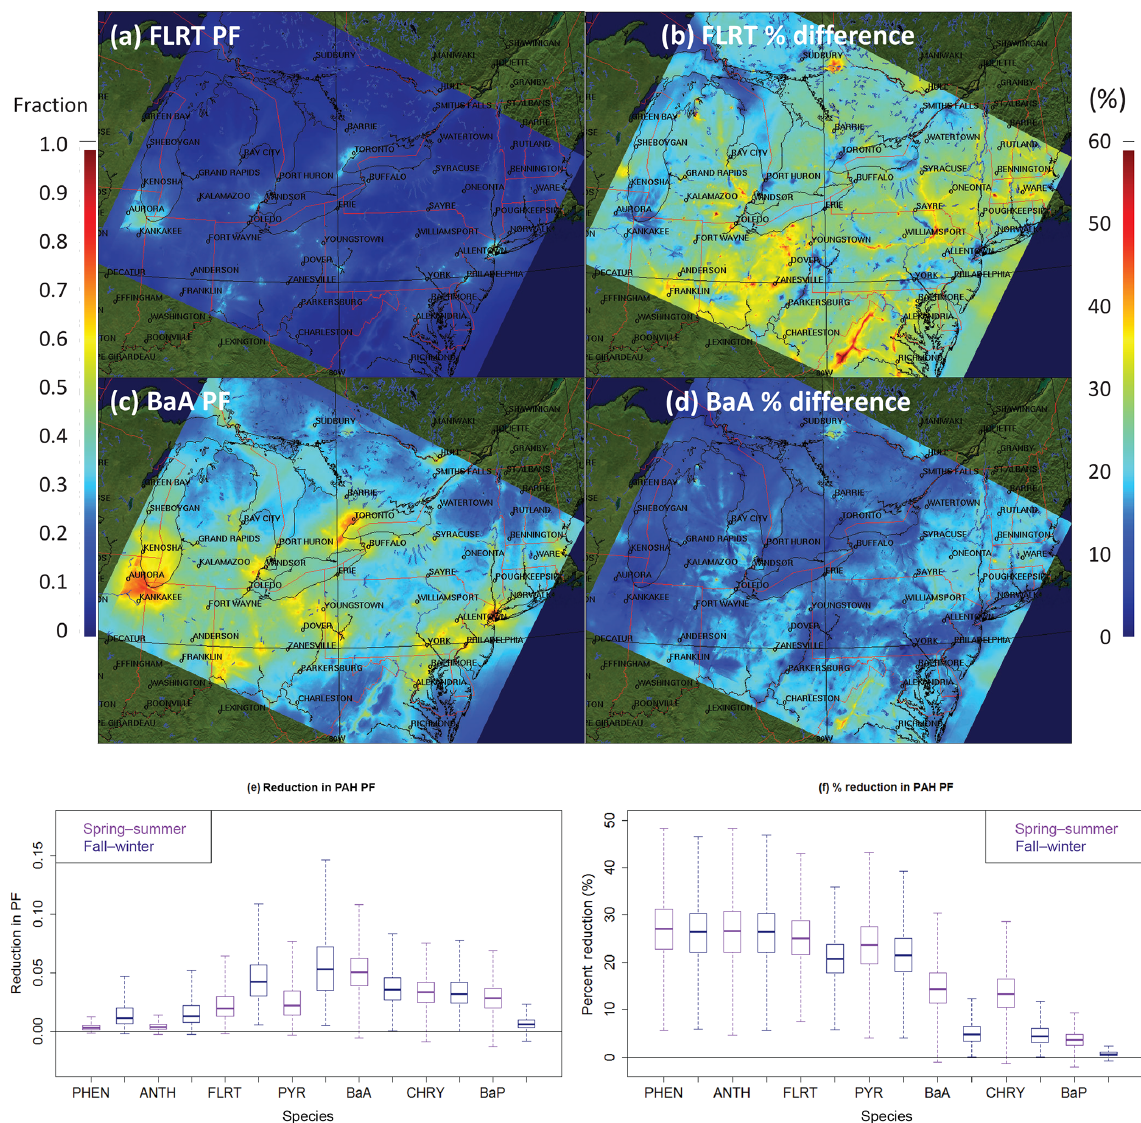
Figure 6. (a, c) Sample maps of particulate fraction (PF) and (b, d) its percent change due to the removal of on-road vehicle emissions. Spring–summer FLRT and BaA are shown as examples. The spring–summer and fall–winter averages of absolute (e) and percent (f) reduction in PF for all PAH species are